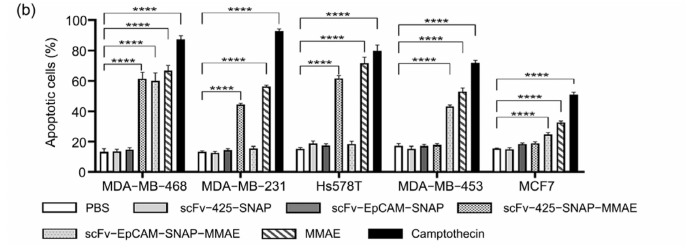
Figure 4. Induction of apoptosis by MMAE, scFv-SNAP fusion proteins and corresponding ADCs. ( a ) Scatter plot of one measurement as an example. ( b ) The sum of early and late apoptotic cells from three independent experiments carried out in triplicate. Data are shown as mean ± SEM. The statisti- cal analysis was carried out using one-way ANOVA and corrected by Tukey’s test (**** p ≤